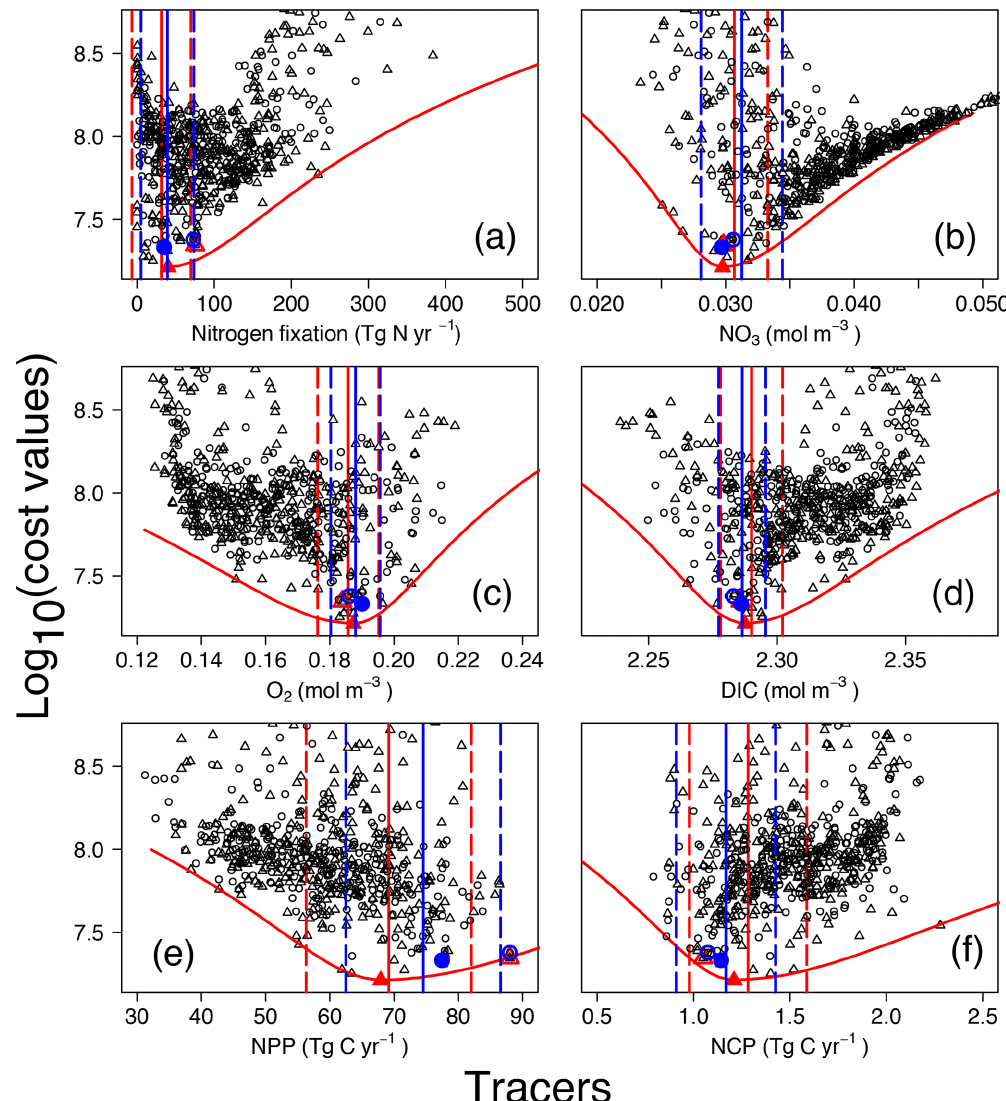
Figure 4. Costs vs. tracer concentrations and fluxes for annual N 2 fixation (a) , globally averaged NO − trations, as well as annual NPP (e) and NCP (here integrated over the depth range 0 to 980m) (f) . Red and blue symbols and lines are for OPEM (triangles) and OPEM-H (circles), respectively. Solid and open symbols represent minimum-cost and trade-off simulations, respec- tively. Vertical solid and dashed lines represent mean and 95% confidence interval of best solutions of 1000 randomly selected subsets of 100 ensemble members. Red parabolas fit the lowest costs at different rates or tracer